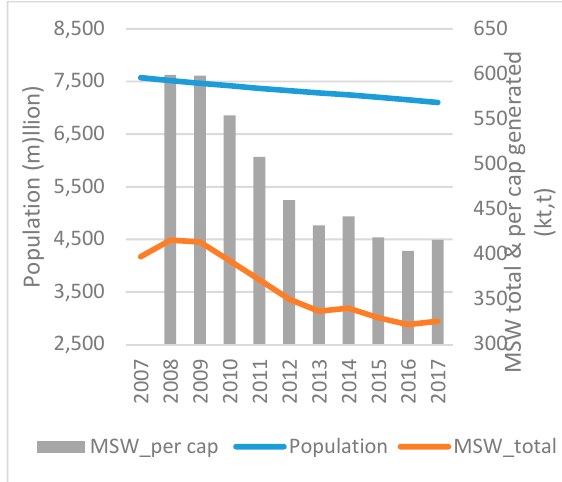
Figure 3. Population and MSW production in Bulgaria 2008–2017 (European Statistics 2019a, 2019c).